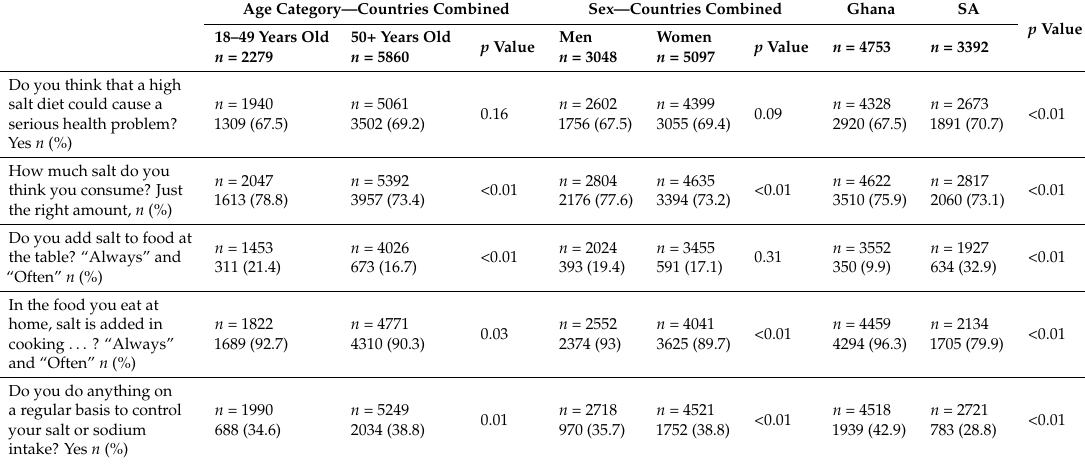
p Value 18–49 Years Old